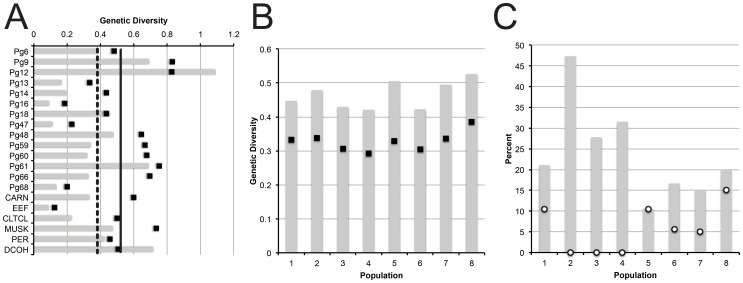
Summary of genetic diversity, mismatch distributions, and neutrality tests.Genetic diversity by locus (A) and by population (B). For both (A) and (B), bars indicate haplotype diversity and dots represent nucleotide diversity. In (B), nucleotide diversity is x100 to match the scale of haplotype diversity. In (C), % of loci per population that are significantly different than the null hypothesis: Bars and dots indicate deviations from mismatch distributions and Tajima’s D neutrality index, respectively.